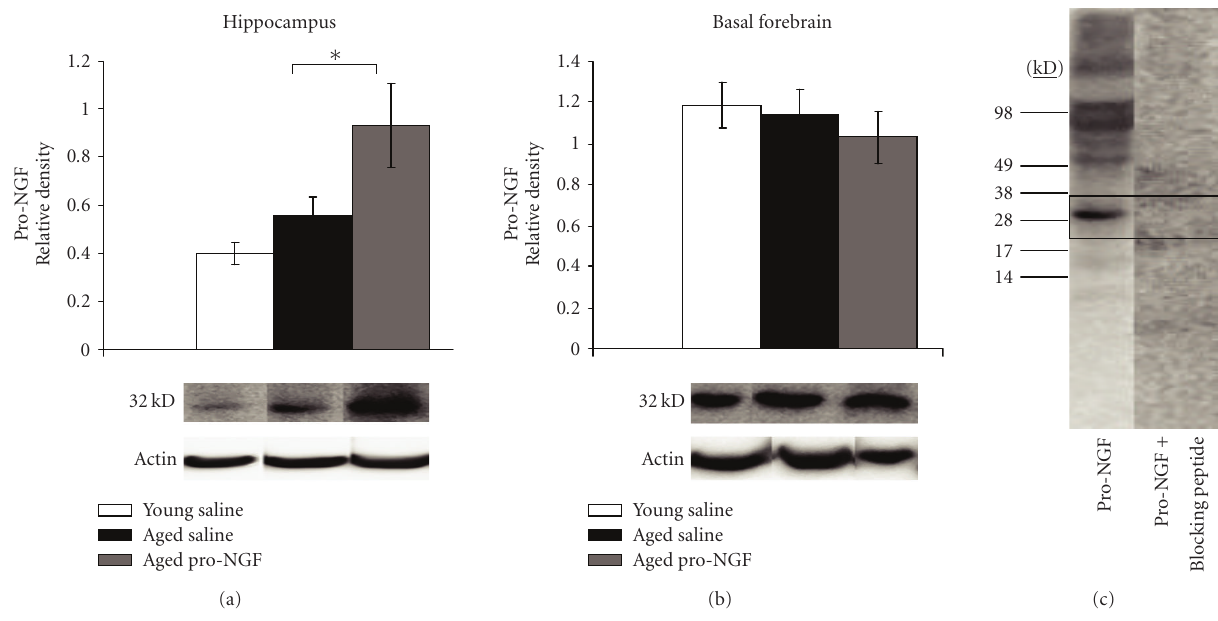
Figure 2: Intra-hippocampal injections of pro-NGF significantly increased hippocampal expression of pro-NGF (a), but did not alter basal forebrain pro-NGF levels (b). The pro-NGF antibody was specific for pro-NGF ( ∼ 32kD) and did not detect mature NGF protein levels as shown in a pro-NGF treated animal; when incubated with pro-NGF blocking peptide, no bands were present (c). Changes in protein levels were normalized to β -Actin; ∗ P ≤ .